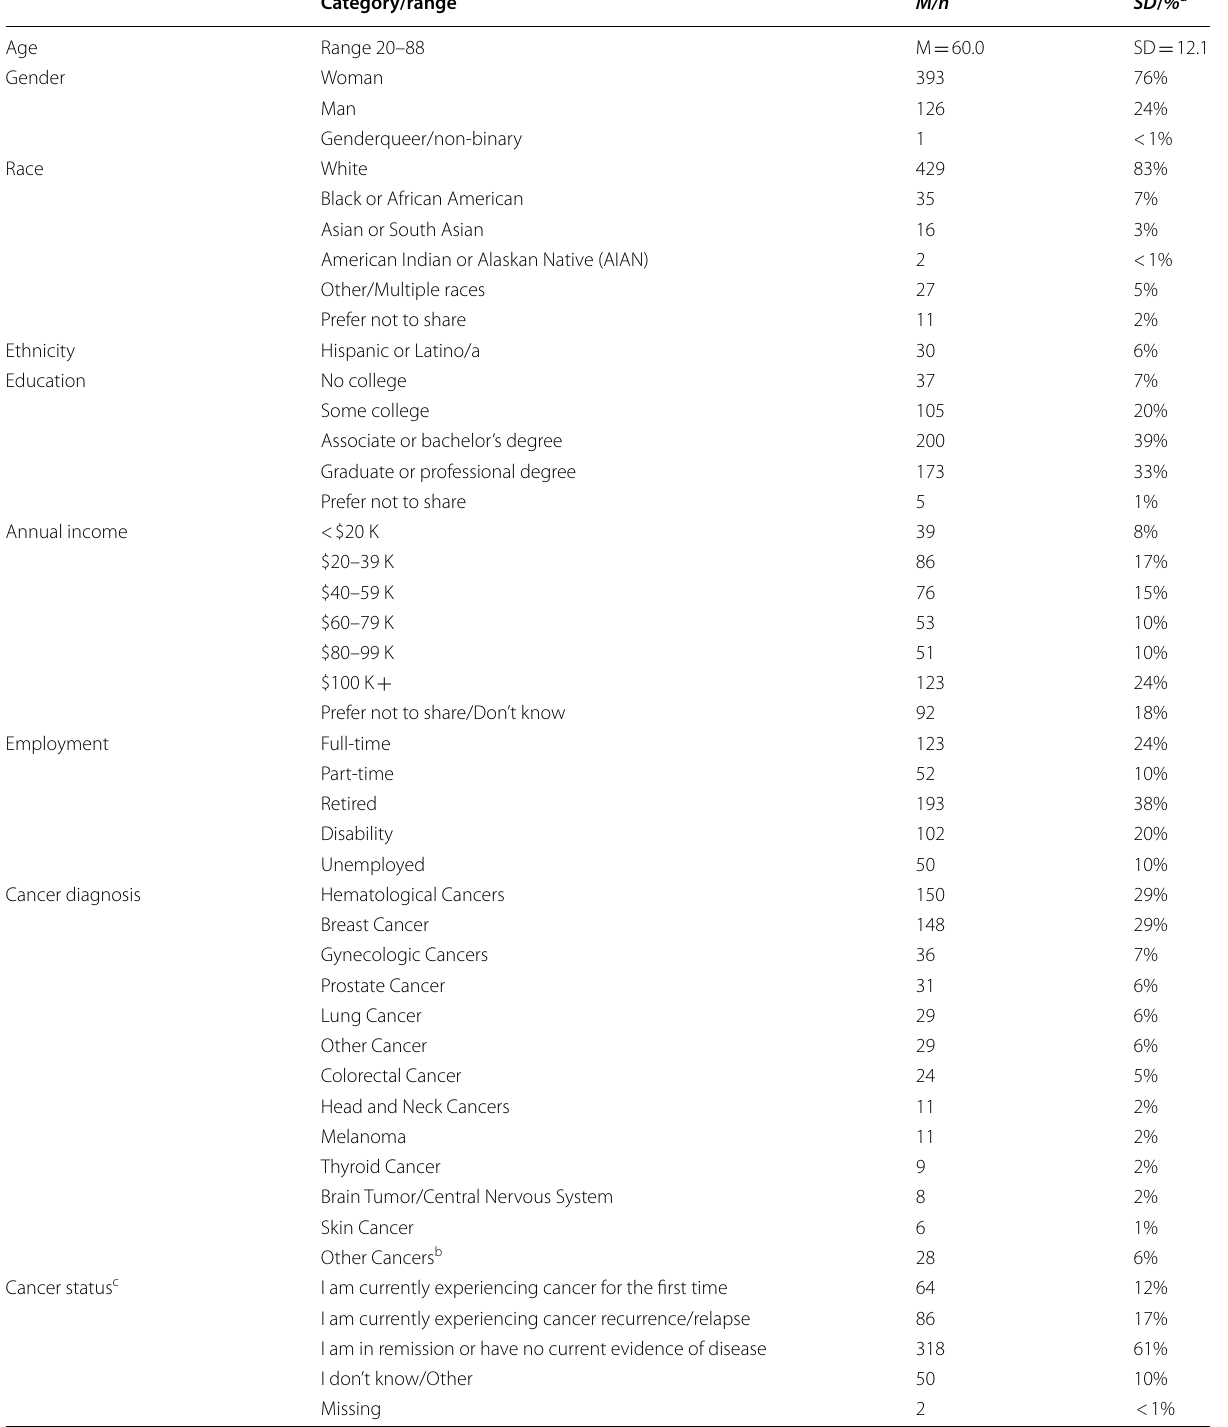
Table 1 Descriptive characteristics of the sample (N